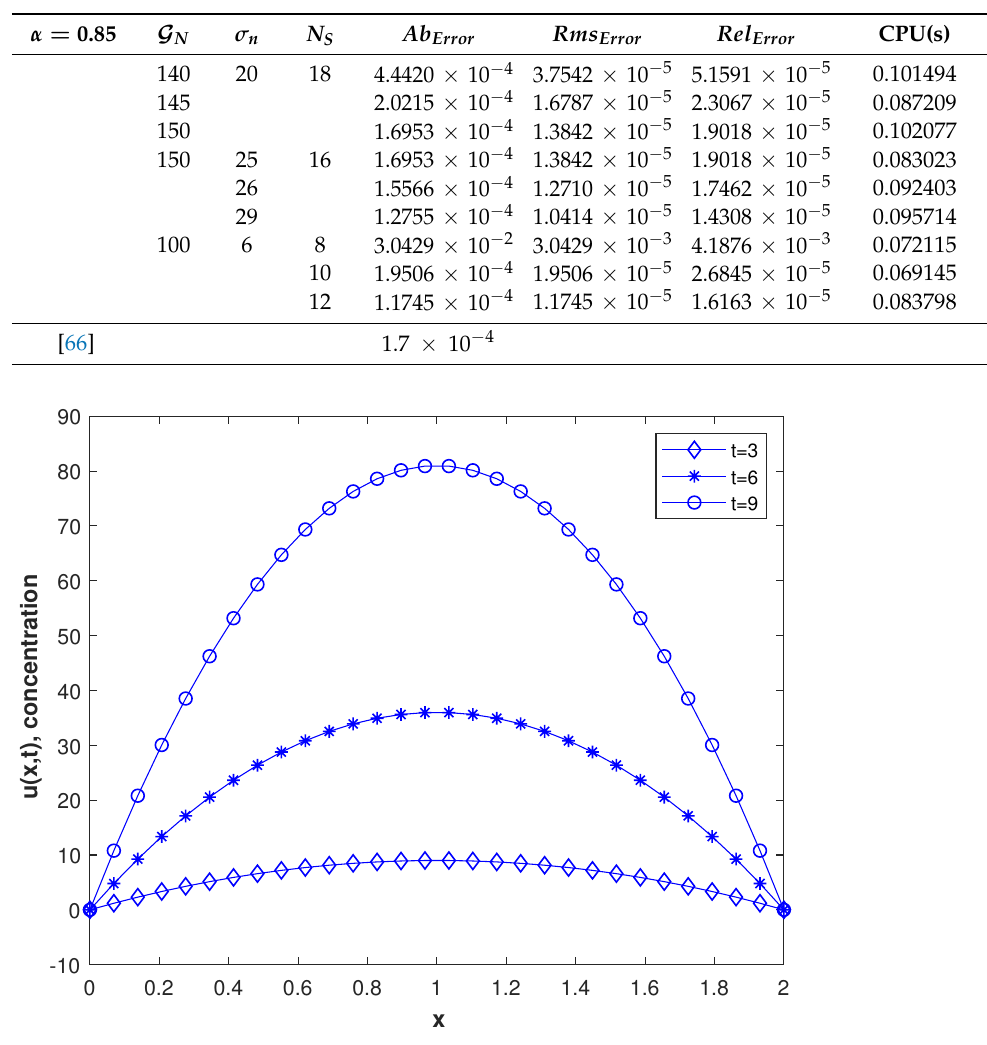
Figure 3. The concentration at different Figure 3: The concentration at different times.